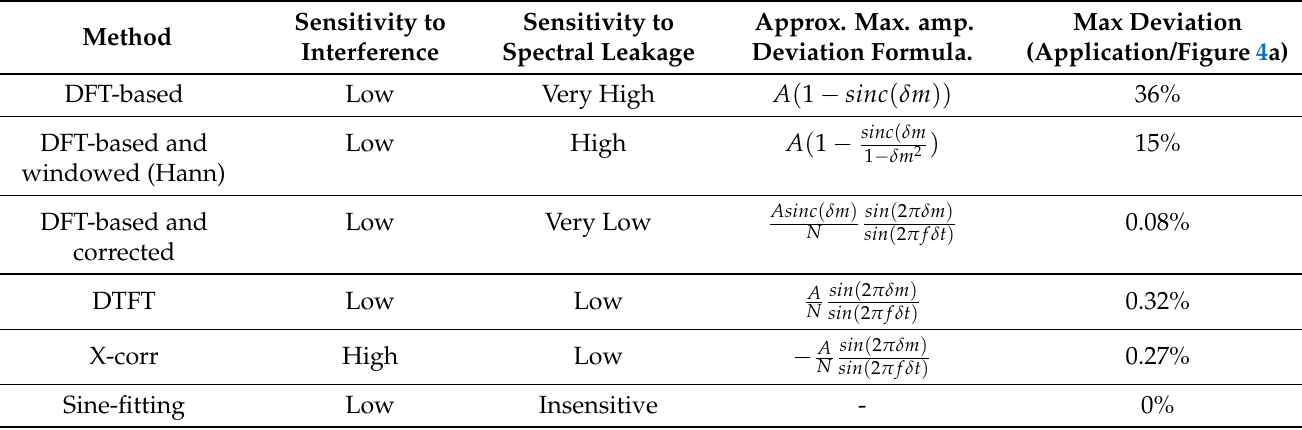
Table 4. Comparison between the sensitivity of the amplitude AC signal analysis methods to interference and to spectral